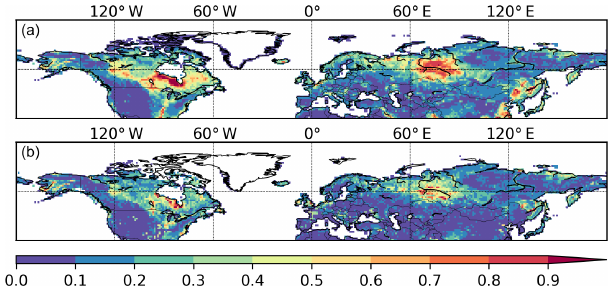
Figure 5. Wetland area fraction from CW-WTD (a) ; simulated max- imum inundation areas (b)